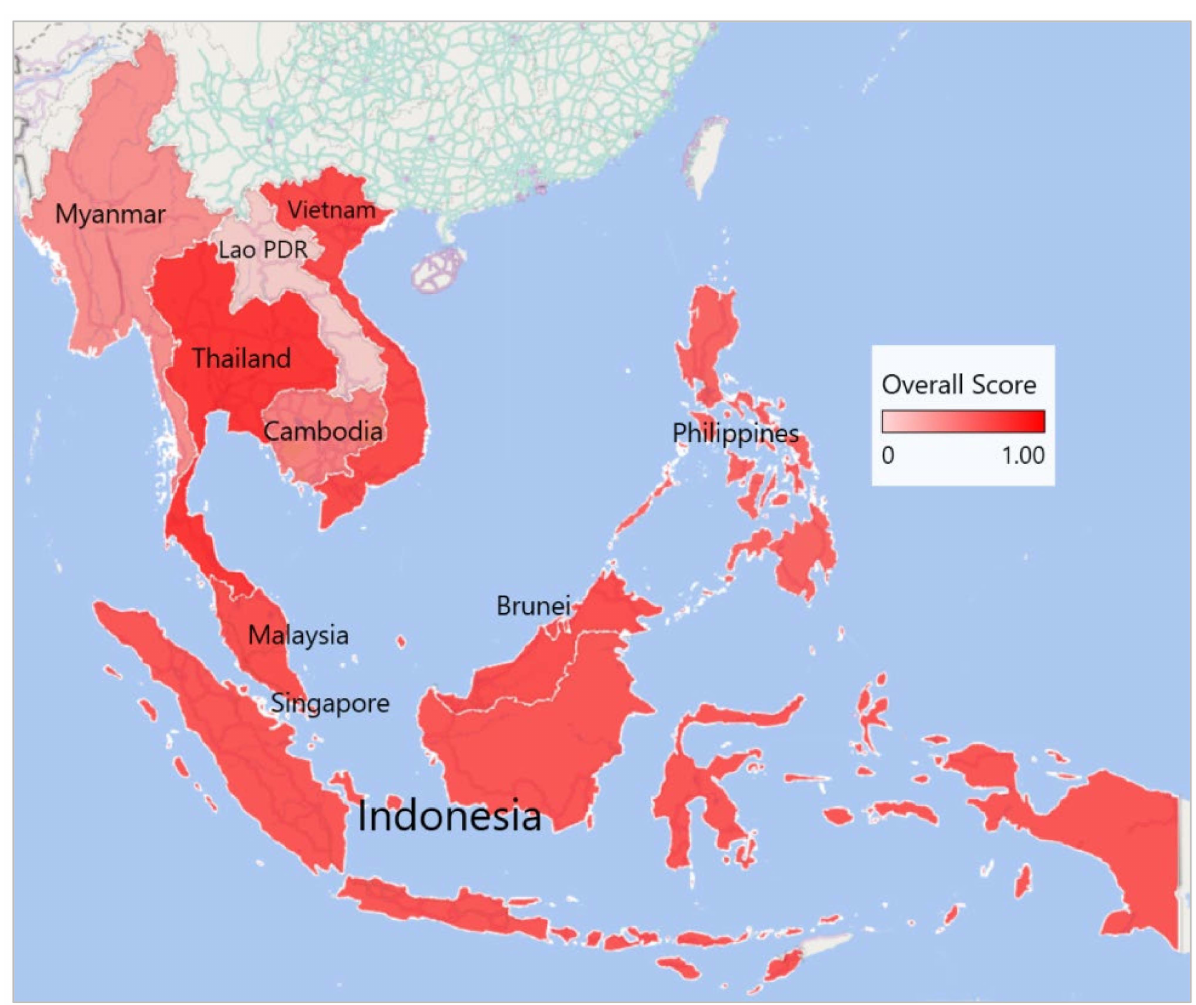
Figure 4. Overall evaluation